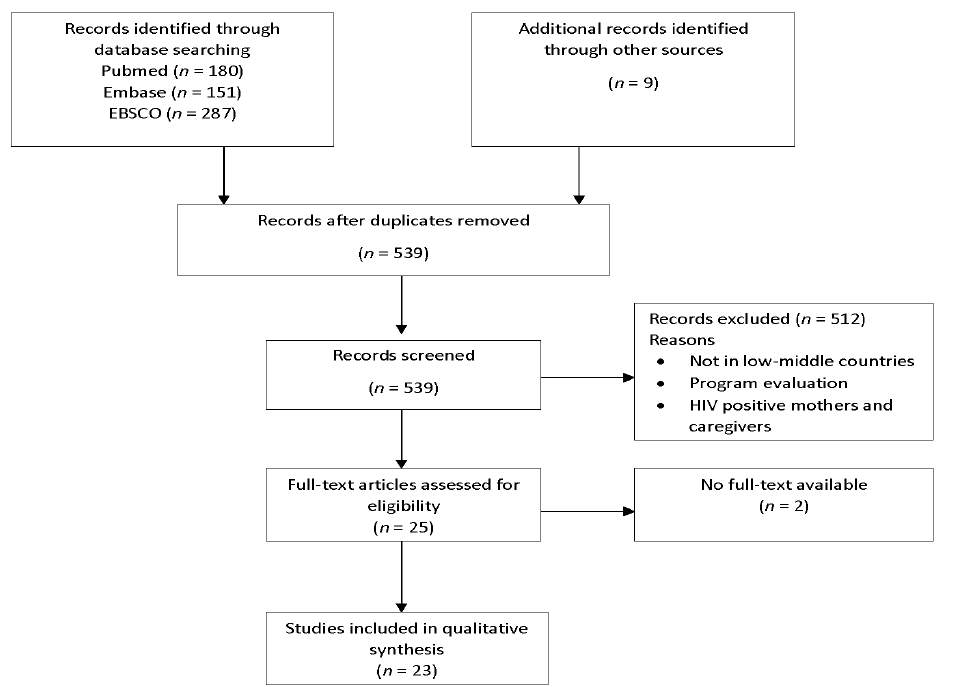
Figure 1. Flow diagram of search results and selection process.